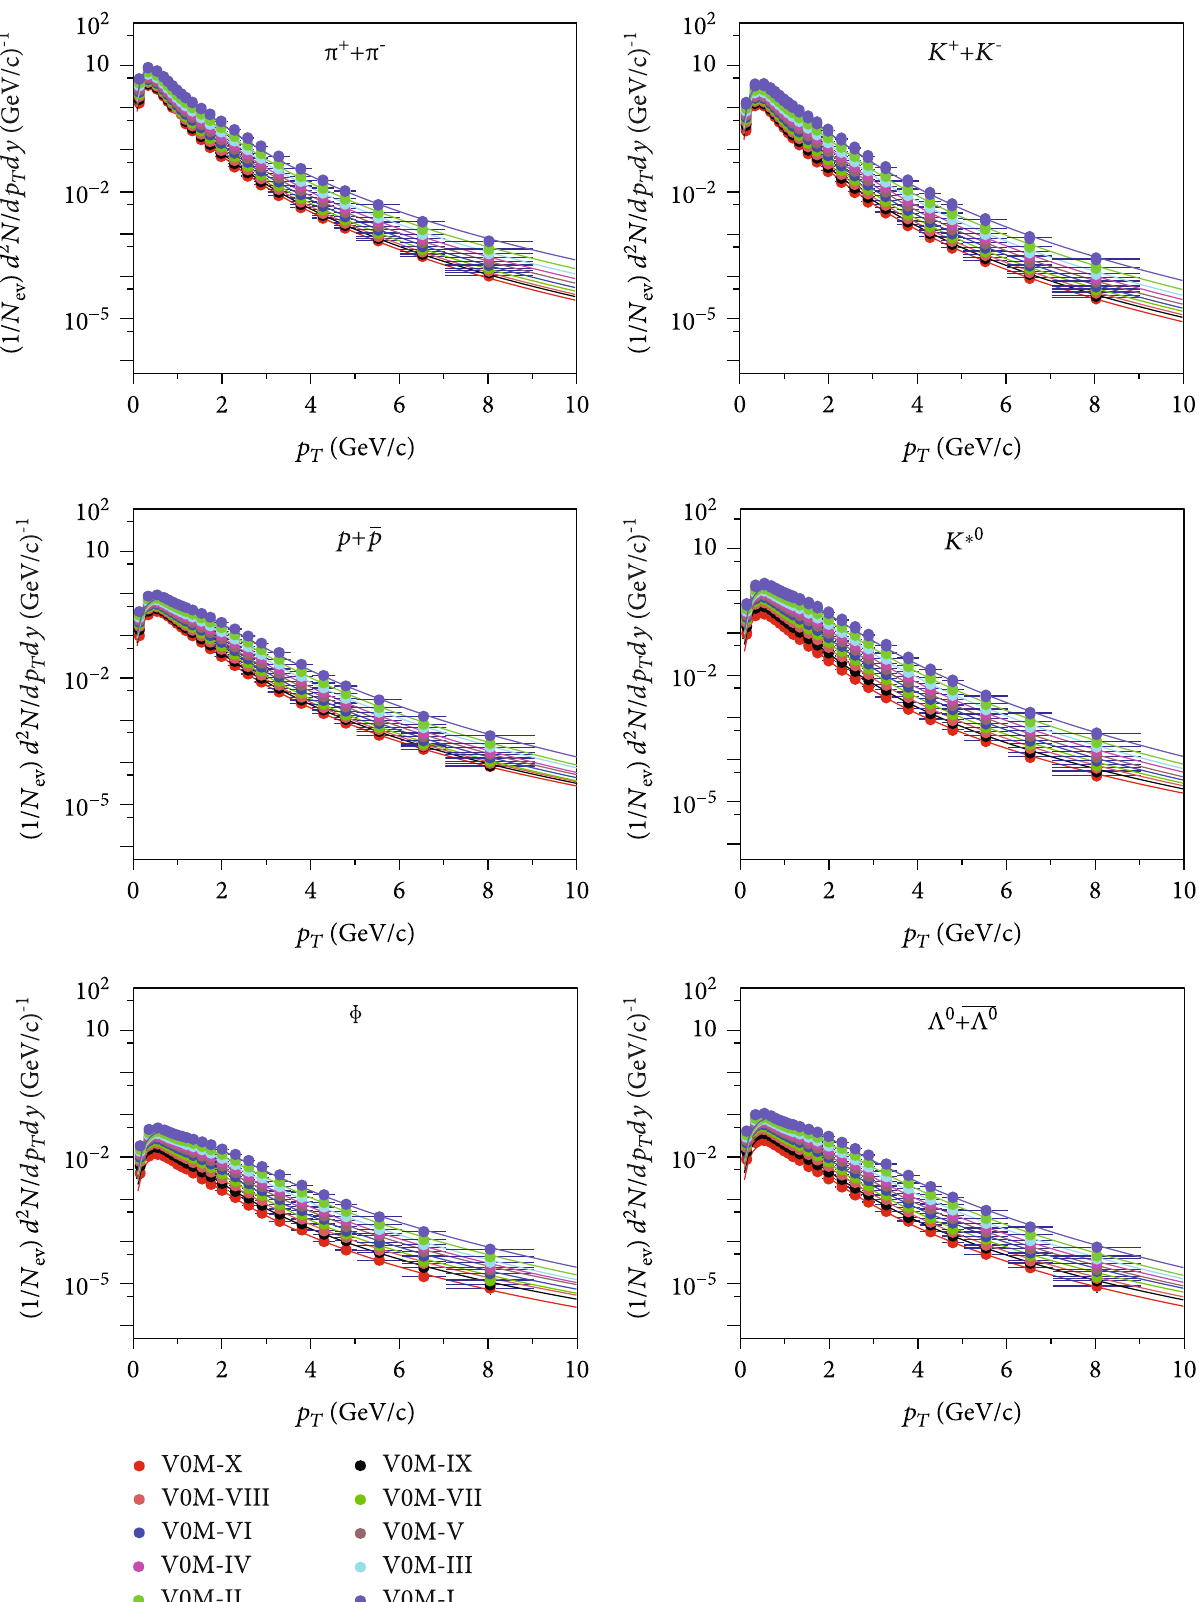
Figure 4: (Color online) Fitting of generated p -spectra of identi fi ed hadrons from PYTHIA8 using Tsallis distribution for spherocity T integrated events in various multiplicity classes as shown in Table